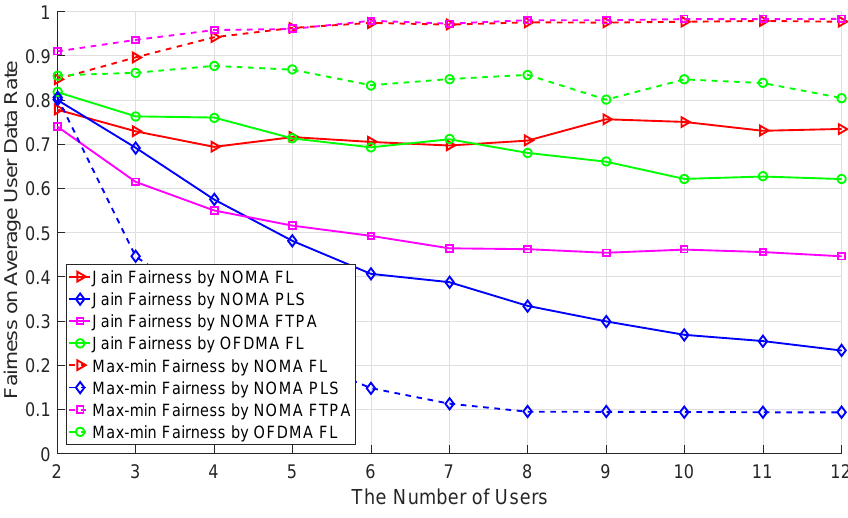
Figure 9. Comparison of fairness with a QoS expectation of 30